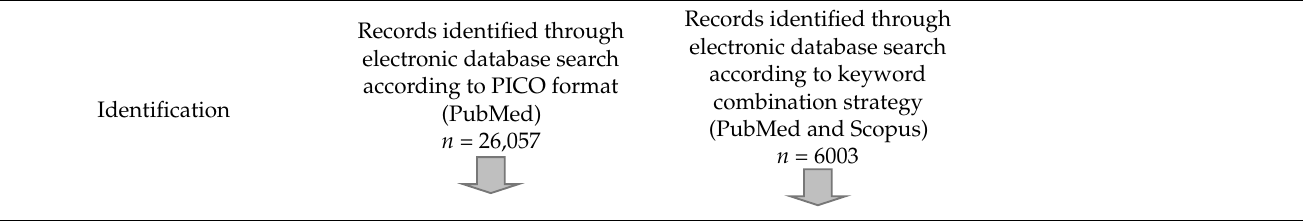
Table 2. Search strategy and results of identification, screening for eligibility, and inclusion of publications considered for review.